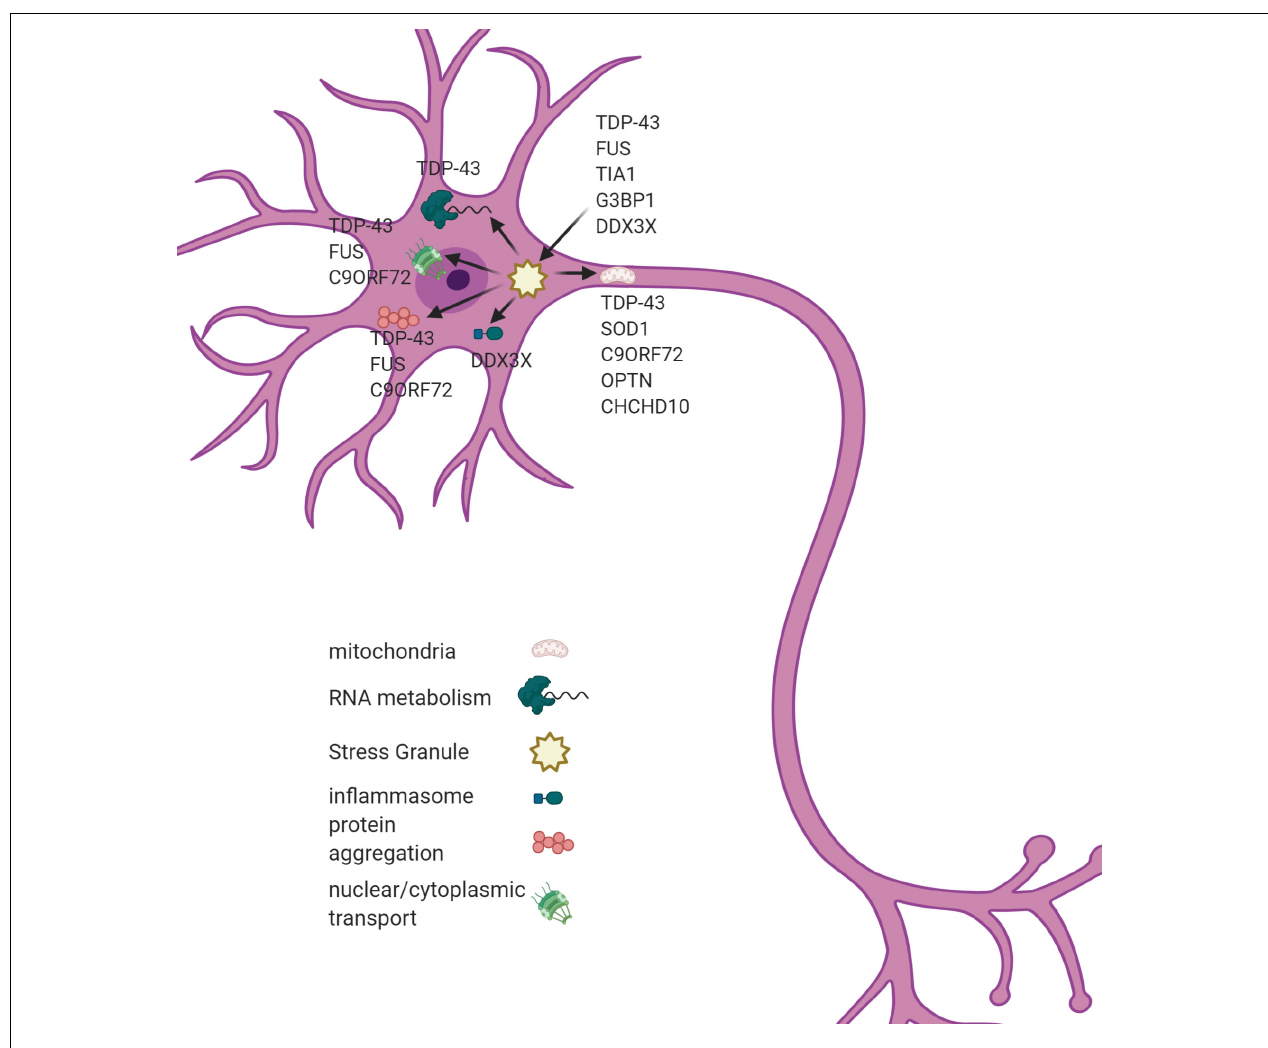
FIGURE 1 | A SGs dysregulation associates with multiple cellular phenotypes in ALS. SGs are hypothesized to act as a seeding mechanism for the pathological aggregations of TDP43 and FUS. SGs also contribute to mitochondrial dysfunction, inflammasome activation, and nucleo-cytoplasmic transport in ALS. Genes associated with each pathological process are listed in the figure. Figure created with